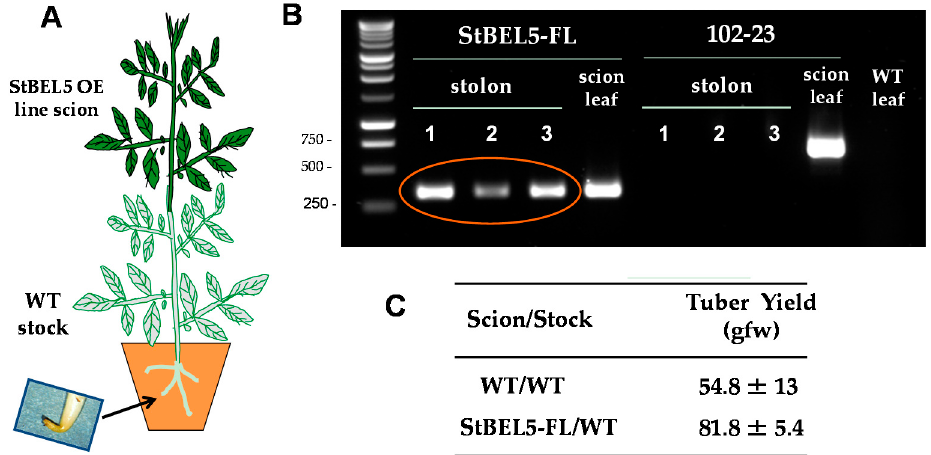
Figure 2. StBEL5 RNA moves through a heterograft graft, and this movement is associated with enhanced tuber yield. Soil-grown wild-type stock plants ( S. tuberosum ssp. andigena ) were grafted with scions from a StBEL5 overexpression line ( A ). After four weeks of long days (LDs) in the greenhouse, grafted plants were transferred to a growth chamber and acclimated under LD conditions for one week before transfer to short-day (SD) conditions. Leaf and stolon tip samples were harvested after 12 days of SD conditions and the RNA extracted. RT-PCR with gene-specific primers was performed ( B ) for both a negative control (a potato MADS box gene, 102-23) and test samples (StBEL5-FL, [full length]). Grafts made from an over-expression line for an antisense sequence of a potato MADS box gene (line 102-23) were used as a non-mobile control. RNA from scion leaf samples was used as a positive control (scion leaf). WT RNA from stolon tips, 0.5 cm in length, was sampled for both heterografts and used in the RT-PCR reactions. PCR was performed twice off a template made from RNA and reverse transcriptase. Two different gene-specific primers were used with a non-plant DNA tag specific for the transgenic RNA to discriminate from the native RNA. Three plants were assayed for both heterografts and are designated 1, 2 and 3. RNA from leaves of a WT/WT autograft was used as a negative PCR control (WT leaf lane). WT is non-transformed andigena line 7540. Similar negative results were obtained with RNA from autograft stolons. For tuber yields ( C ), plants were harvested after 28 days, and the mean of three plants was calculated for WT and StBEL5 grafted plants. WT scions grafted onto WT stocks were used as the yield controls. gfw, grams fresh weight. With permission of the authors [9].